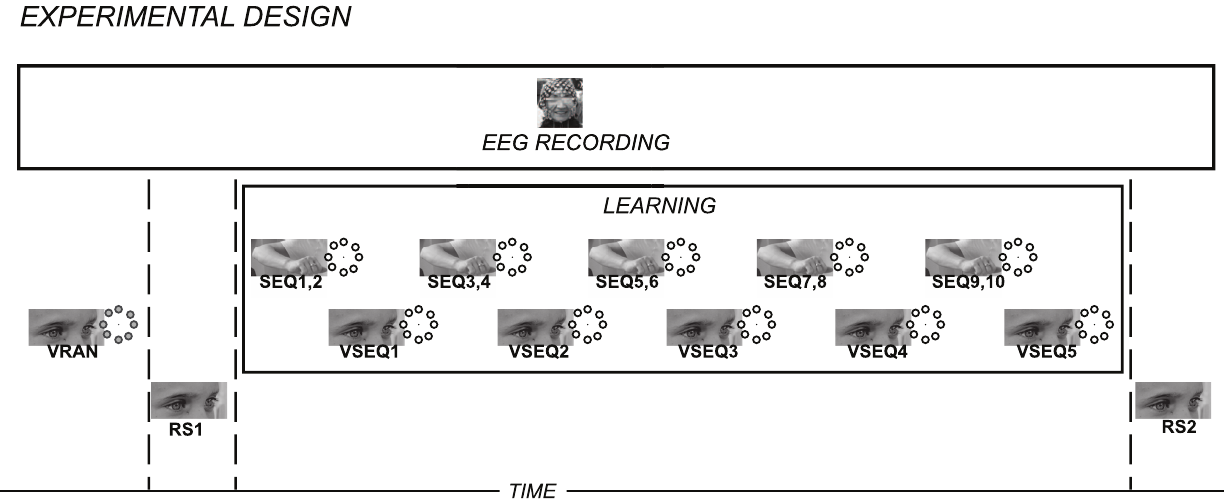
Figure 1. Experimental design for sequence learning. First, subjects performed three blocks of VRAN, a control task for VSEQ, where targets appeared randomly and instructions were to maintain attention avoiding eye movements. Then, three-minute resting state EEG was recorded (RS1), followed by alternating blocks of visuo-motor (SEQ) and visual (VSEQ) sequence learning tasks. At the end of the session, three-minute resting state EEG was recorded (RS2). The eight-target array is represented nearby each block. Please note that the subject of the photograph has given written informed consent, as outlined in the PLOS consent form, to publication of their photograph.